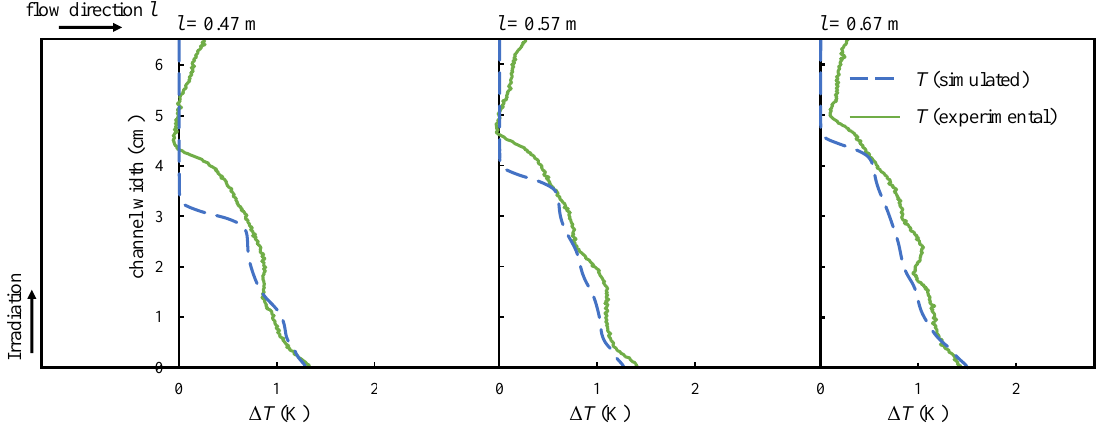
Figure 16. The results for higher flow velocity confirm the good agreement between experiments and